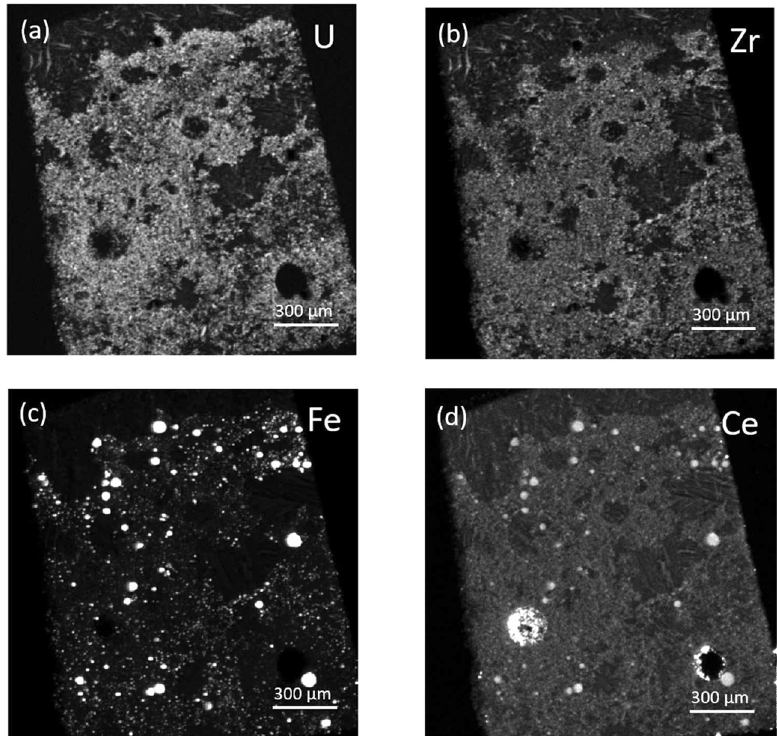
Fig. 5 Micro-focus XRF maps of MCCI-3. Showing distribution of a U-L α , b Zr-K α , c Fe-K α and d Ce-L α fl uorescence signals. White regions indicate areas of high concentration, while black areas indicate regions with no concentration. Scale bar on all images is 300 µm.